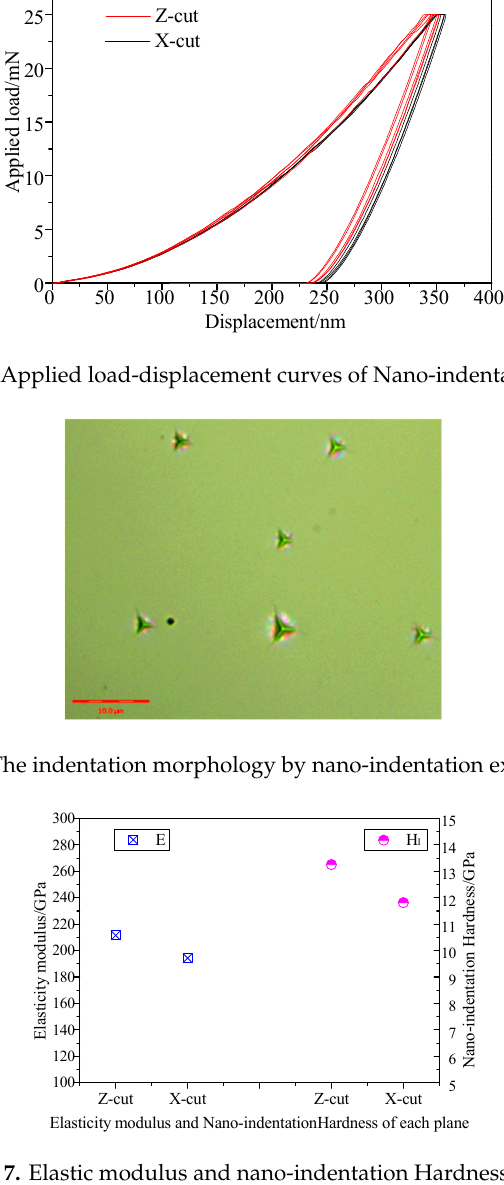
Figure 7. Elastic modulus and nano-indentation Hardness of LN.